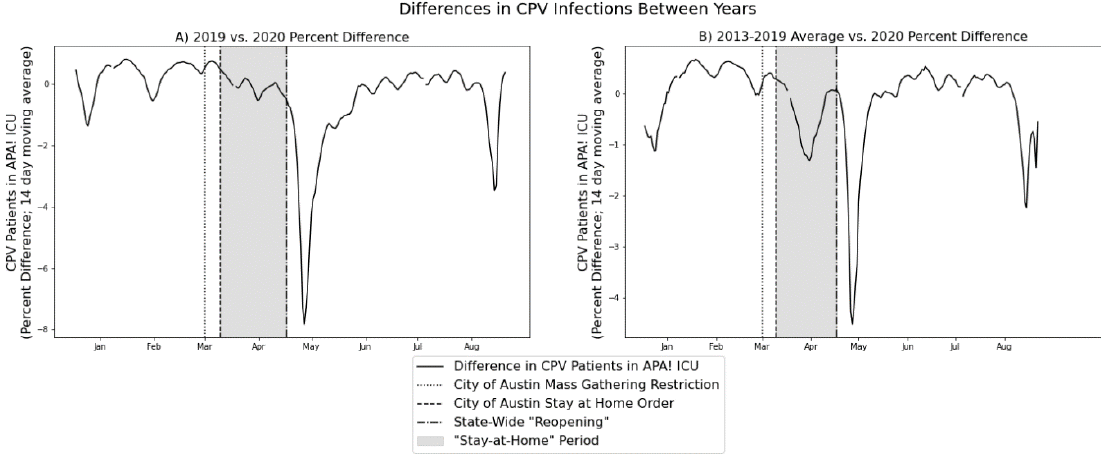
Figure 1. Average canine parvovirus (CPV)-infected animals over time. This figure, presented solely to illustrate the raw data under consideration in this work, shows the average population of CPV- infected animals in the intensive care unit (ICU) during 2019 and 2020 as well as the historical average ICU population from 2013 –2019. The period of “ stay-at-h ome” orders which lasted from 24 March 2020 until the Texas state- wide “ r eopening” on 01 May 2020 is highlighted (gray shading). Note the large difference between the 2019 and 2020 data which occurs immediately following the state-wide “ r eopening”. Additionally, the monthly count of at -home treatment animals (all Travis County sourced) is shown for 2019 and 2020, and, although no difference is seen during the low period in May, a large upswing in at-home care patients is seen as CPV season begins. All data are presented in two-week moving averages.